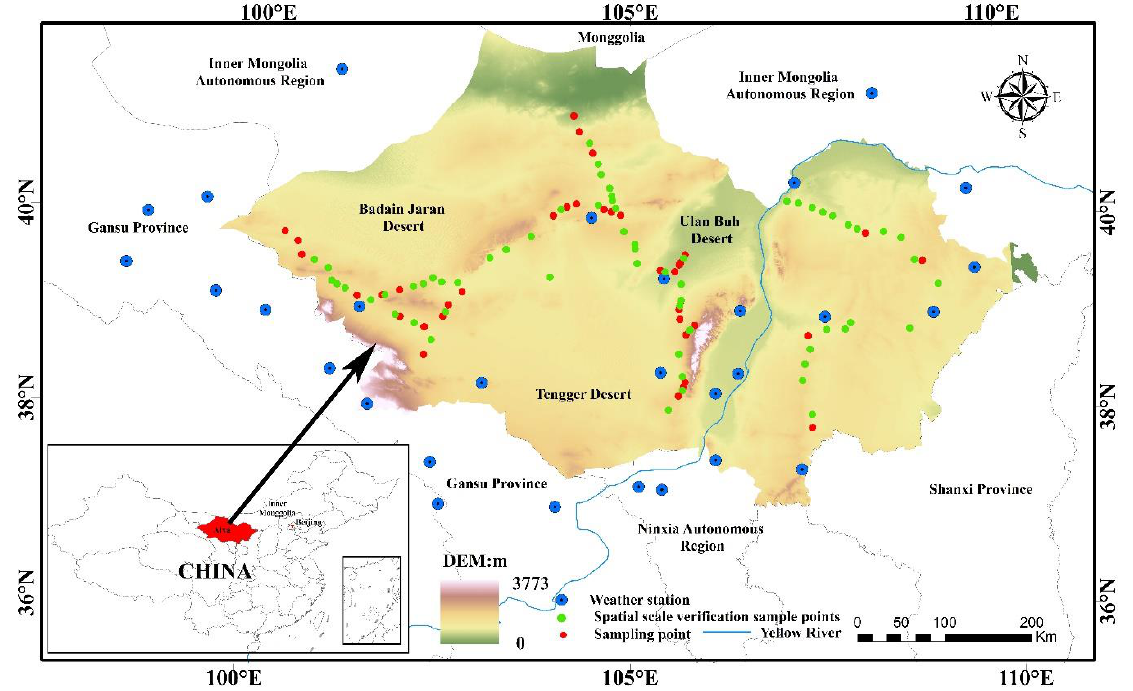
Figure 1. Spatial distribution of sampling points and weather stations. Red dots and green dots are sampling points, where the green dots are also the points of spatial scale verification, and the blue dots are weather stations. To avoid the influence of human activities on the test results, we chose the plots that are less affected by human activities as the sampling plots; the sample area is flat, and the vegetation type is as simple as possible.